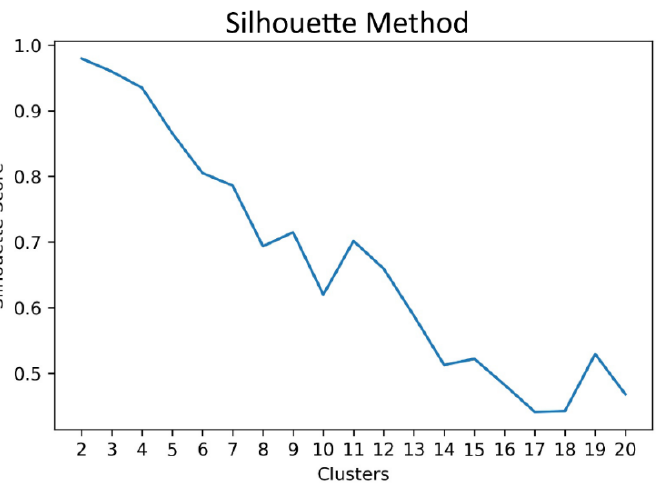
Figure 13. Silhouette method for clusters ranging from 2 to 20 using K-means clustering of client load profiles based on dynamic time warping.